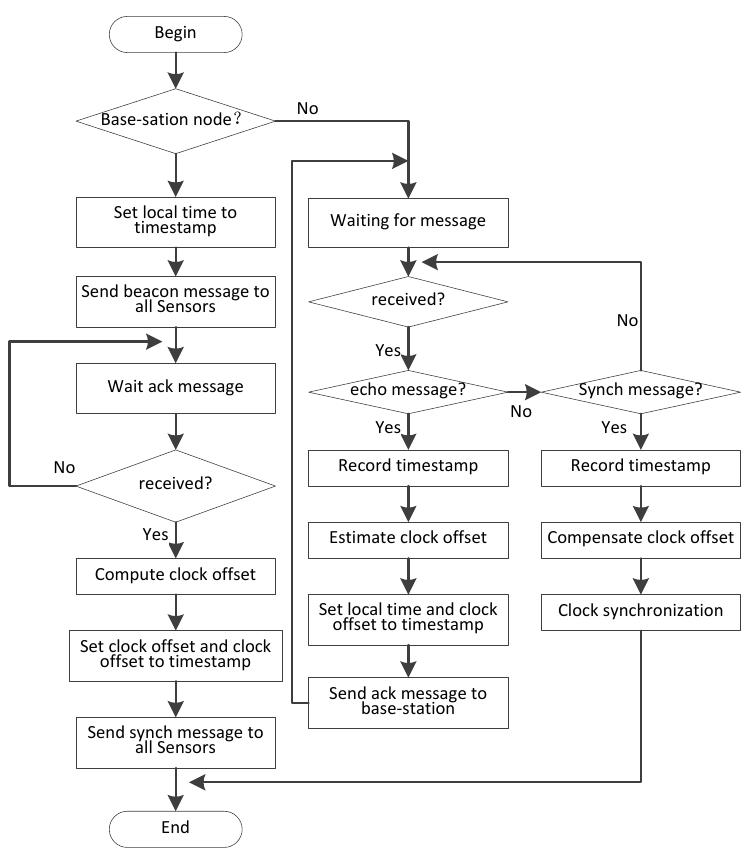
Figure 7. The flow chart of sensor synchronization.